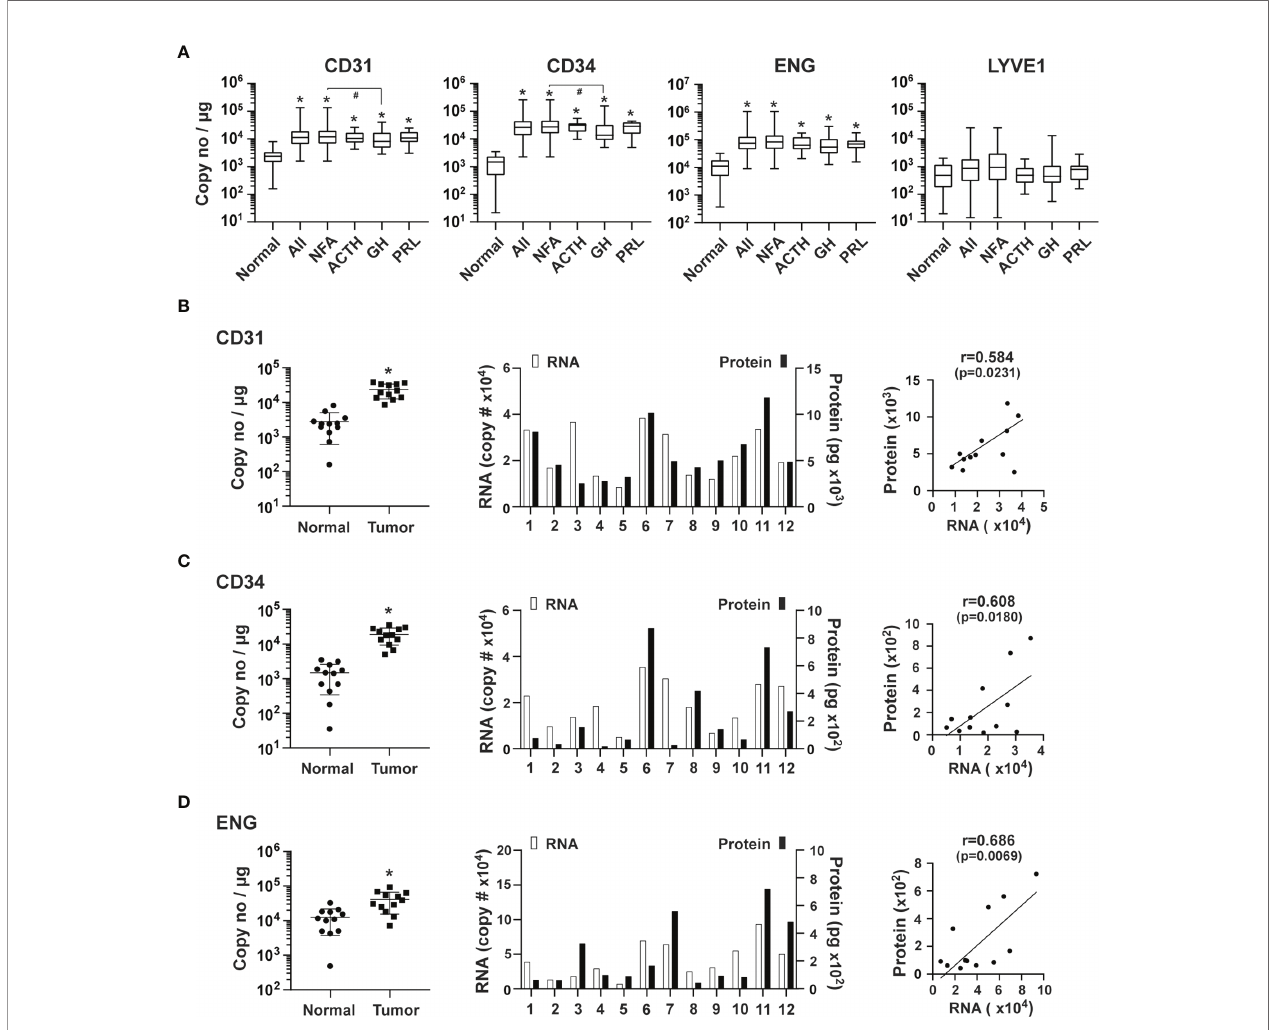
FIGURE 2 | Expression of endothelial markers in human pituitary tumors. (A) Expression of the indicated genes was quanti fi ed by the TaqMan ® probe-based qPCR. A total of 207 human pituitary tumors, including 140 NFAs, 38 GH-producing, 16 ACTH-producing and 13 PRL-producing tumors, and 12 normal pituitaries were assessed. *p < 0.05 vs normal pituitaries; #p < 0.05 vs NFA. (B) CD31, (C) CD34 and (D) ENG: Correlation of their RNA and protein expression in an additional 12 pituitary tumors, including 11 NFA and 1 GH-secreting tumors. Left panel , RNA levels of endothelial markers in pituitary tumors and normal pituitary tissue. *p < 0.05 vs normal pituitaries. Middle panel , RNA and protein levels of individual pituitary tumors. RNA levels (open bars) are indicated on the left y-axis as copies of transcript/ m g total RNA. Protein levels (solid bars) are indicated on the right y-axis as pg/mg of tumor tissue. Right panel , correlation between RNA levels determined by qPCR and protein levels determined by ( Figure 3A ). As a non-angiogenesis gene control, GAPDH expression was determined to be 7.6 x 10 6 copies/ m g total RNA.